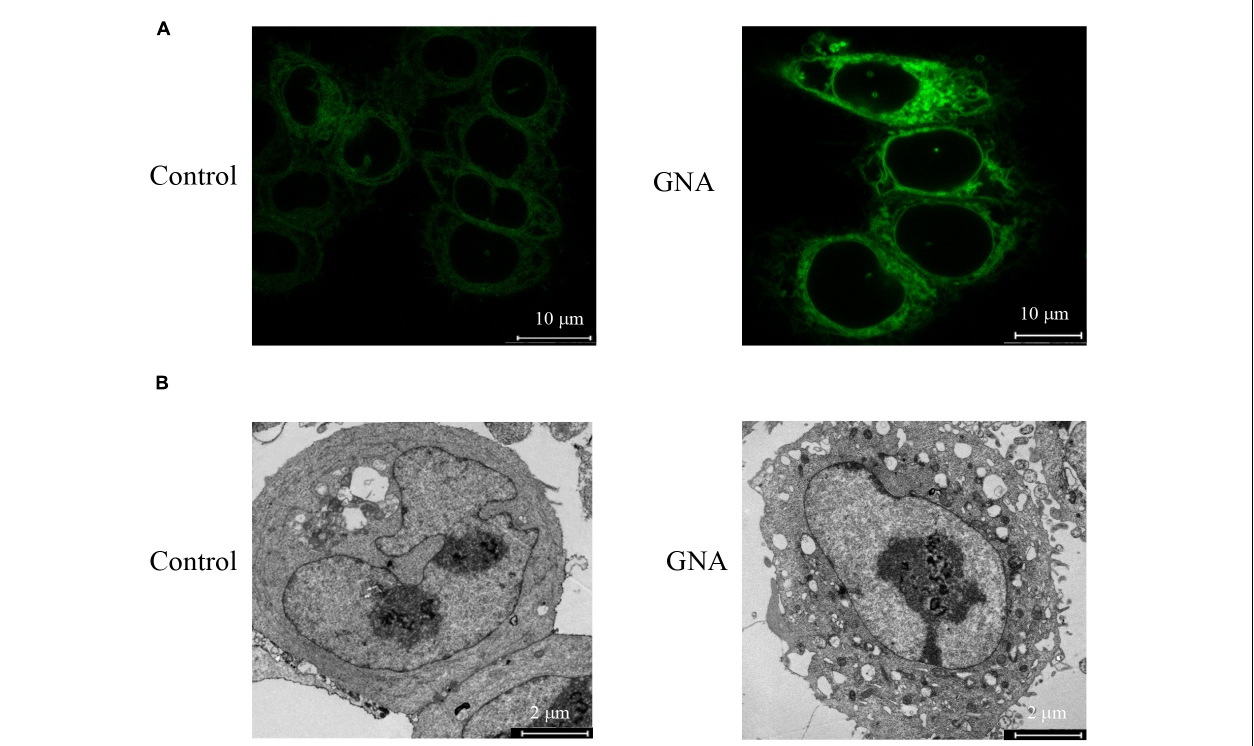
FIGURE 2 | GNA activated ER stress in cells. (A) HCT116 cells were treated with GNA for 6 h, and then incubated with ER-tracker TM Green (1 µ M) for 30 min. ER tracker staining fluorescence was observed by confocal laser scanning microscopy (scale bar = 10 µ m). (B) HCT116 cells were treated with GNA (1 µ M) for 24 h, and then the morphology of the ER was observed under TEM (scale bar = 2 µ m). The data are presented for at least three independent experiments.